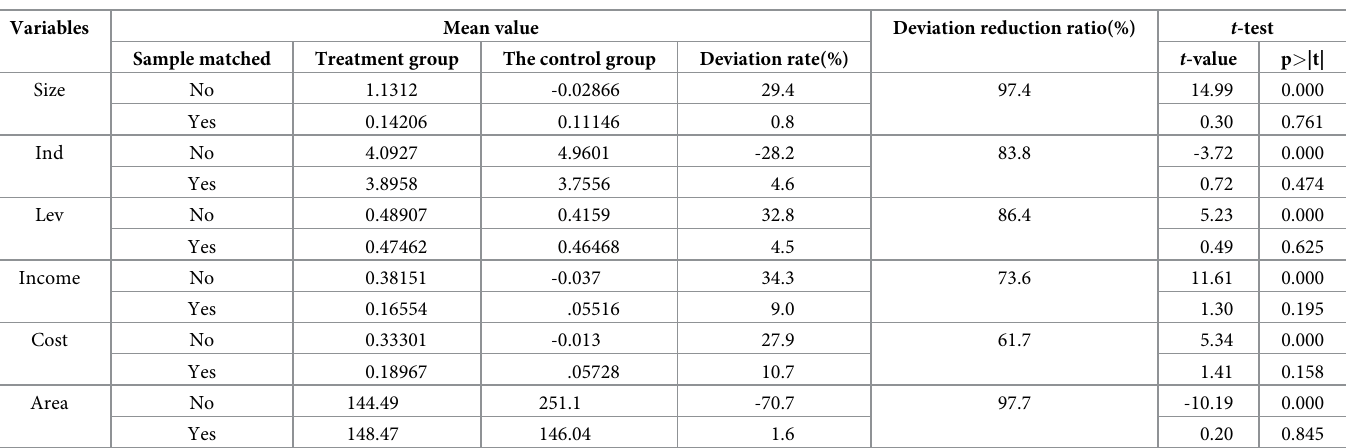
Table 4. PSM balance test